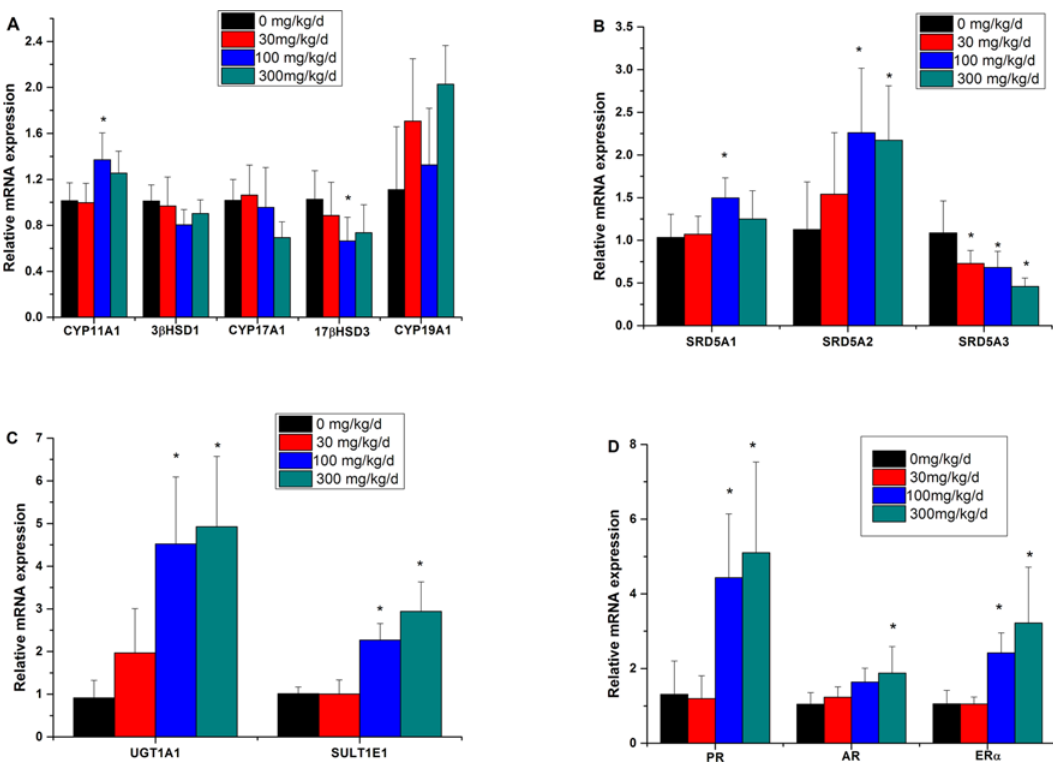
Fig 4. Relative expression levels of genes related to hormone biosynthesis and metabolism in the placenta. (A) Placental mRNA levels of CYP11A1, 3 β -HSD1, CYP17A1, 17 β -HSD3 and CYP19A1. (B) Placental mRNA levels of SRD5A1, SRD5A2 and SRD5A3. (C) Placental mRNA levels of UGT1A1 and SULT1E1. (D) Placental mRNA levels of PR, AR and ER α . The data represent the relative mRNA expression compared with the controls. Values are given as the mean ± SD of n = 18 (placenta) per group. * p <